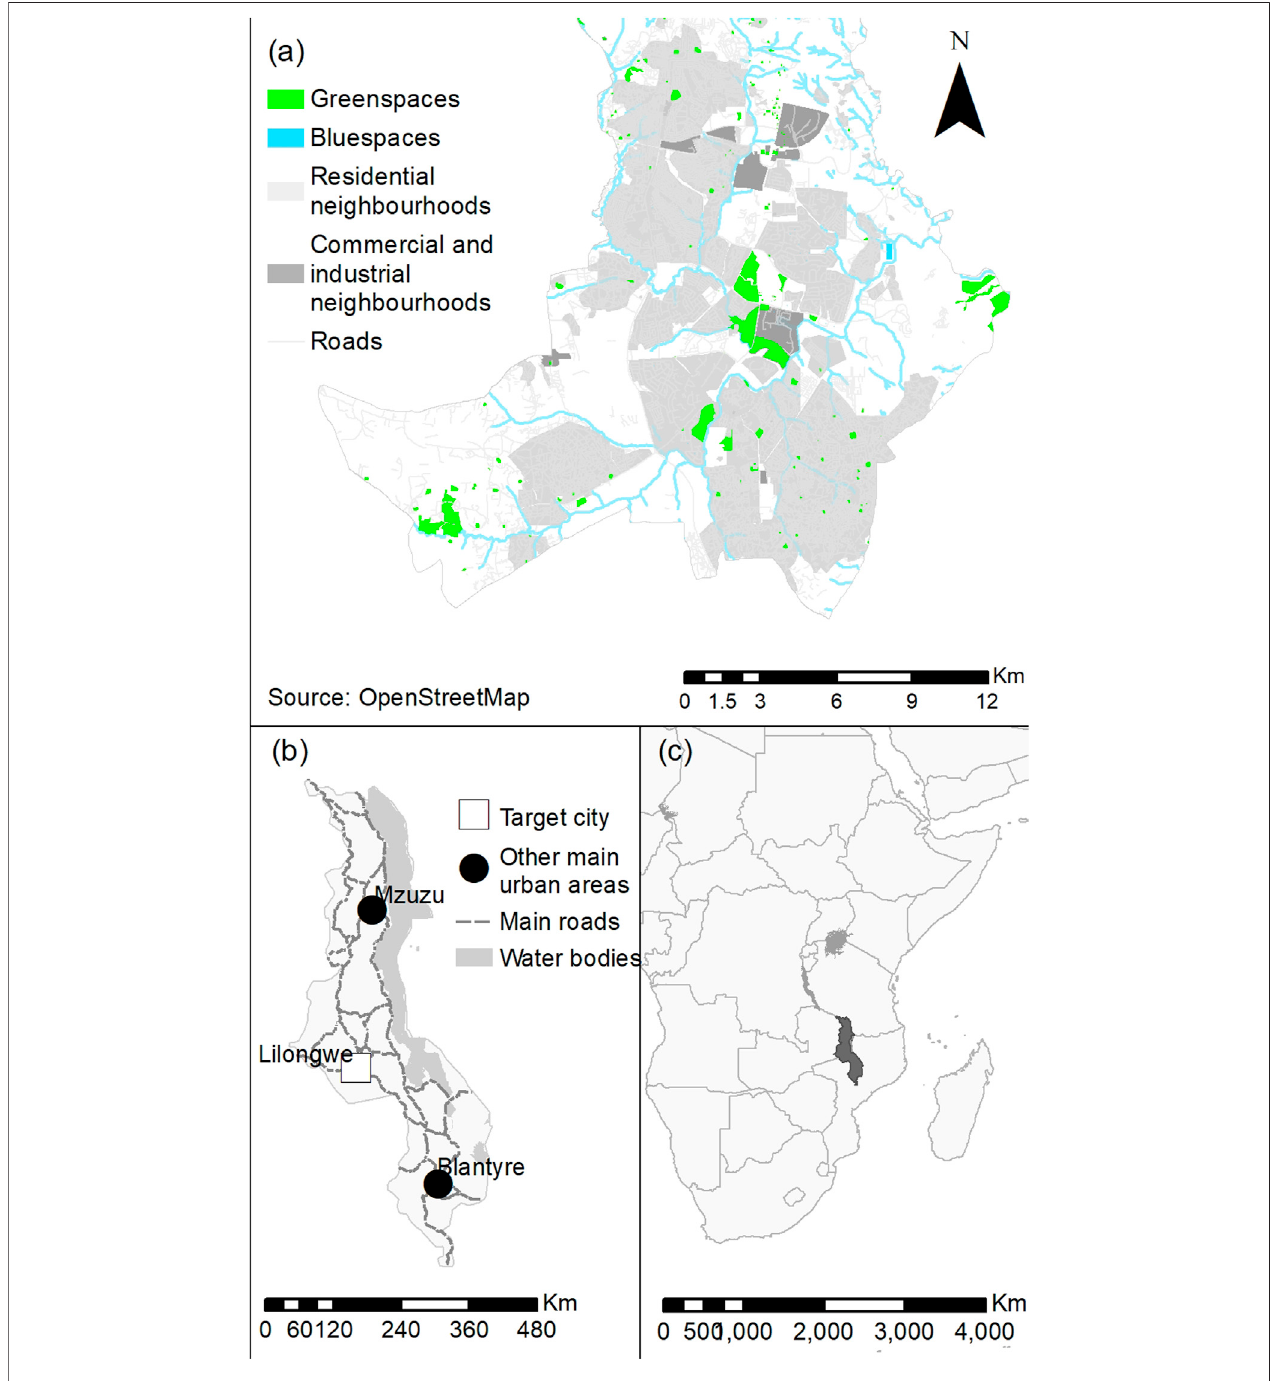
FIGURE1| ThecityofLilongwe,showingneighbourhoodsandgreenspaces (A) ;thelocationofLilongwewithinMalawi (B) ;andthelocationofMalawiinAfrica (C) .